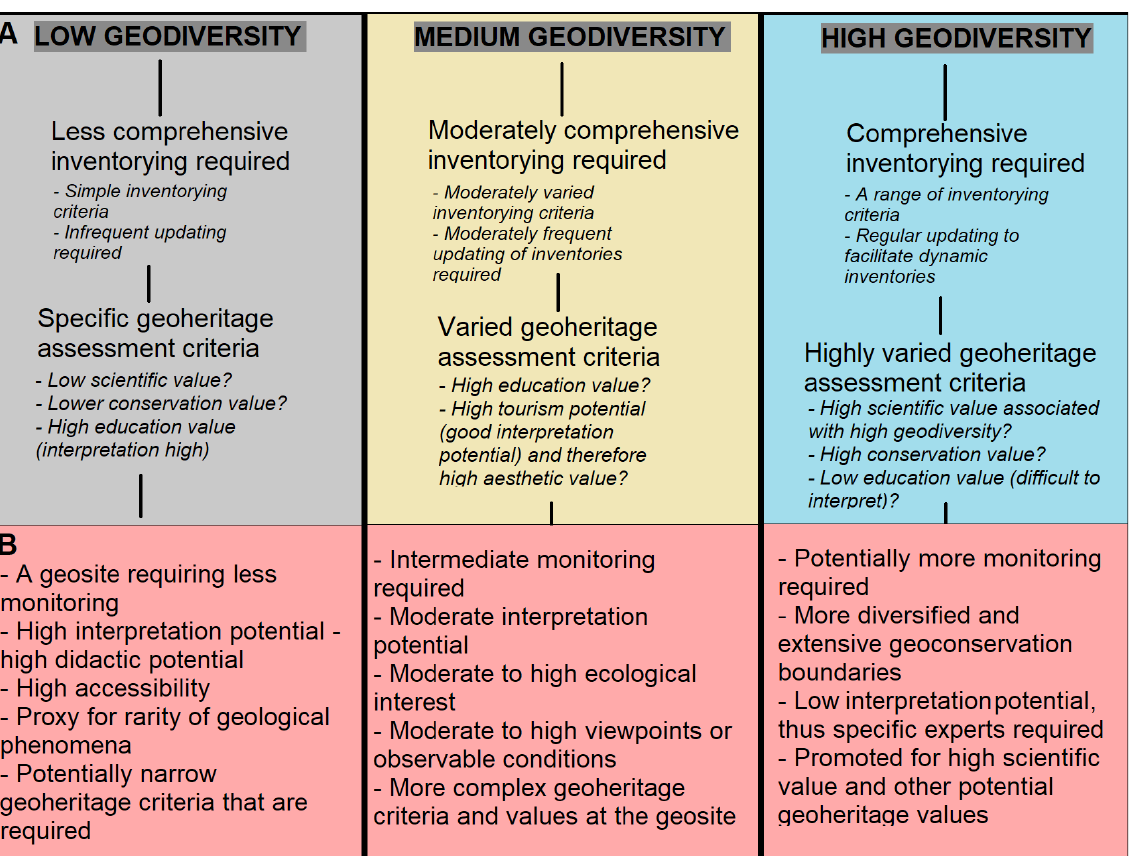
Figure 6. A conceptual model highlighting the benefits to geoconservation outcomes of including geodiversity in geoconserva- tion strategies. A) An overview of how acquiring a specific geodiversity value may consolidate processes in the inventorying and geoheritage assessment of geosites. B) An overview of how acquiring a geodiversity value may consolidate all geoconser- vation